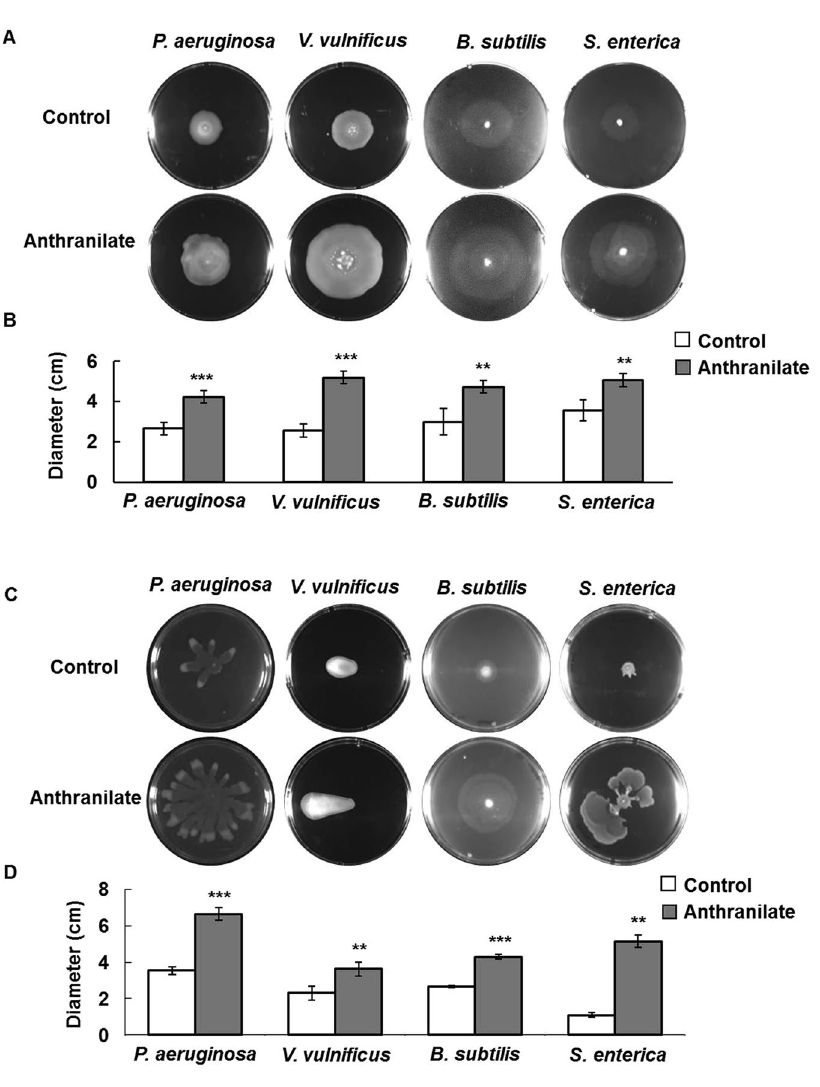
Figure 7. Effect of anthranilate on bacterial motility Swimming motilities of the bacterial strains were examined on semi-solid agar plates in the presence of 0.1 mM anthranilate ( A ). Diameters of swimming zones were graphed ( B ). Swarming motilities were also measured on solid agar plate containing 0.1 mM anthranilate ( C ) and diameters of swarming zones were graphed ( D ). ** p < 0.01; *** p <